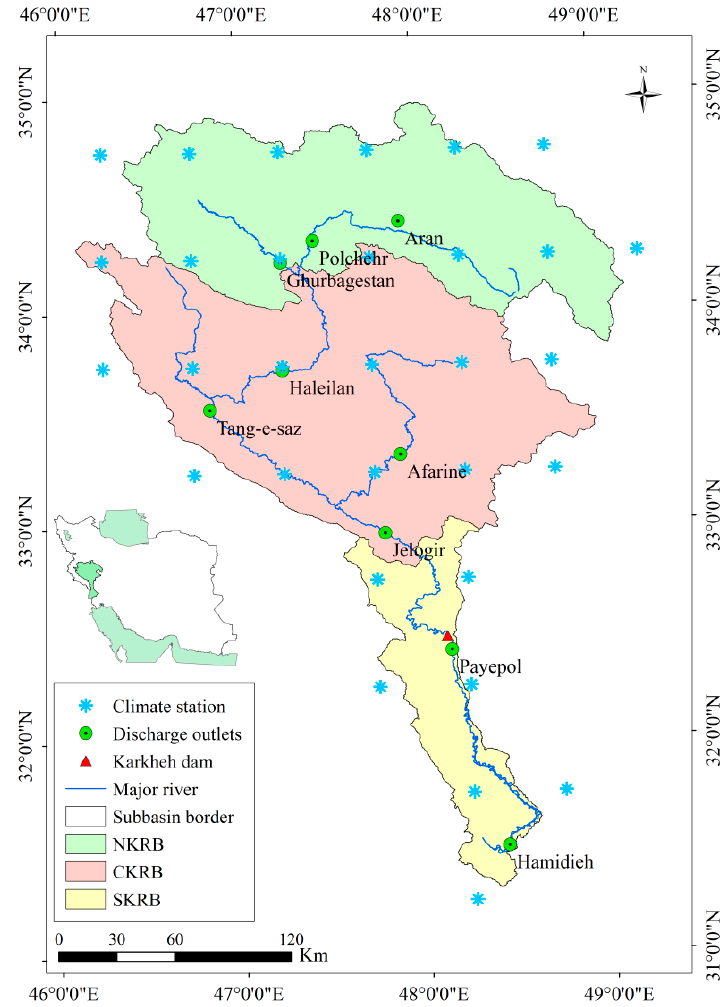
Figure 1. The Karkheh River Basin (KRB) and the three major catchments (Northern Karkheh (NKRB), Central Karkheh (CKRB), and Southern Karkheh (SKRB)). The figure shows the main river, Karkheh dam, 31 climate stations, and 9 observed discharge outlets used for calibration.